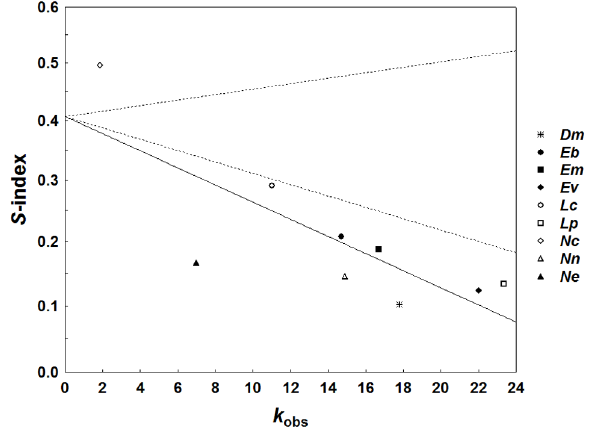
Figure 3. Association of the effective-number-index of pater- nity skew ( S -index) and mean observed paternity frequencies ( k obs ) across the nine army ant species (represented by different symbols) for which S was estimated. The solid line indicates the slope of a phylogenetically corrected GLS regression ( b =– 0.005, R 2 =0.63, p =0.003) and dashed lines the 95% confidence interval of expected slopes with the same intercept under random paternity distribution. These were estimated from 100 Monte Carlo iterations of the GLS regression with randomly generated S -values (see text and Jaffe´ et al. [47] for details). An observed slope below the confidence limits is significantly steeper than expected from random.